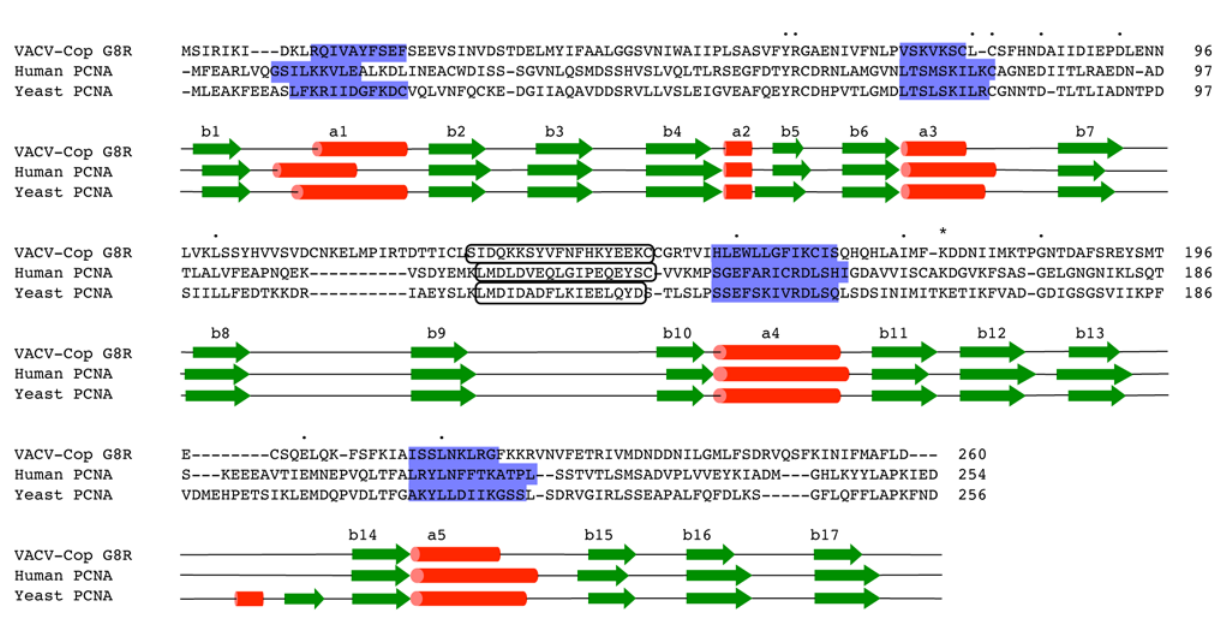
Figure 1. Comparative alignment between VACV G8R, human and yeast PCNA. Alignment created using T-Coffee alignment algorithm, default parameters, with minor adjustments made by hand [20]. Green arrows represent beta-strands, and red cylinders represent alpha-helices. Black rounded box shows the interdomain connecting loop, blue shaded boxes represent the helices that contribute to DNA binding and dots represent identical residues between the 3 protein sequences. Residue marked with an asterisk is the conserved ubiquitylation/SUMOylation site. Secondary structure was derived directly from the crystal structures of the human and yeast PCNA proteins and the structural model of the VACV G8R protein.